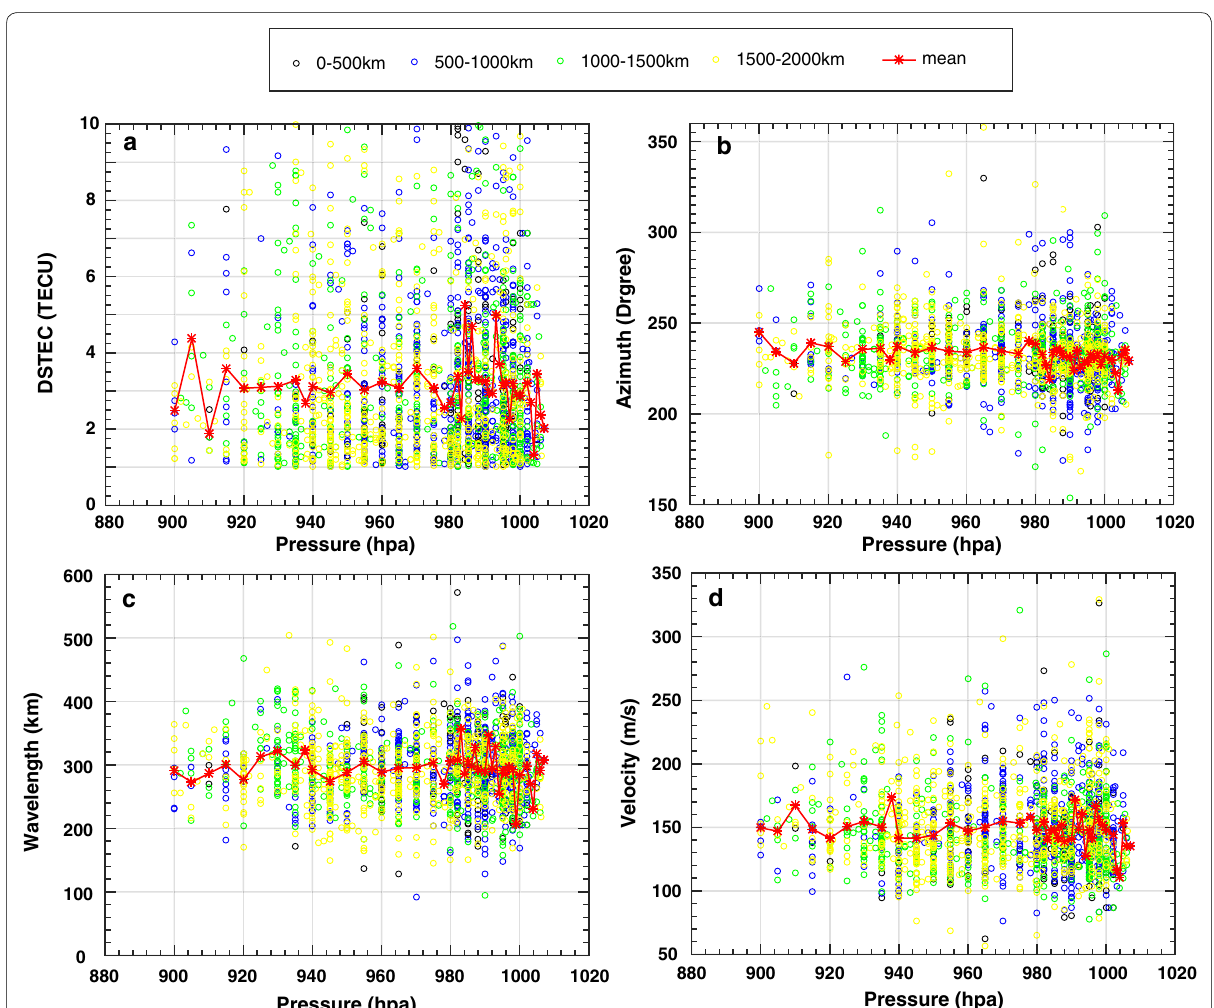
Fig. 10 Correlation between cyclone pressure and DSTEC ( a ), azimuth ( b ), wavelength ( c ) and velocity ( d ). The black, blue, green and yellow circles represent the distance between the center of the cyclone and Hong Kong, which are 0–500 km, 500–1000 km, 1000–1500 km and 1500–2000 km, respectively, and the red curves correspond to the mean parameter values in each cyclone pressure